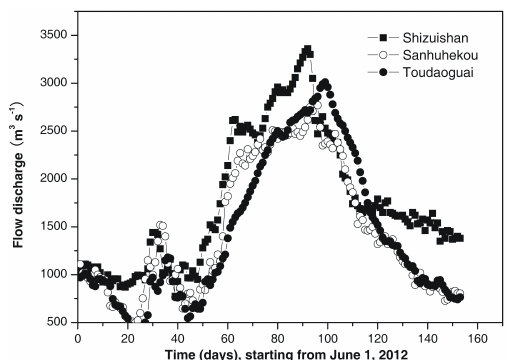
Figure 6. Flow discharges monitored in three gauges (Shizuishan, Sanhuhekou and Toudaoguai) in the braided and meandering chan- nels during the passage of a flood in